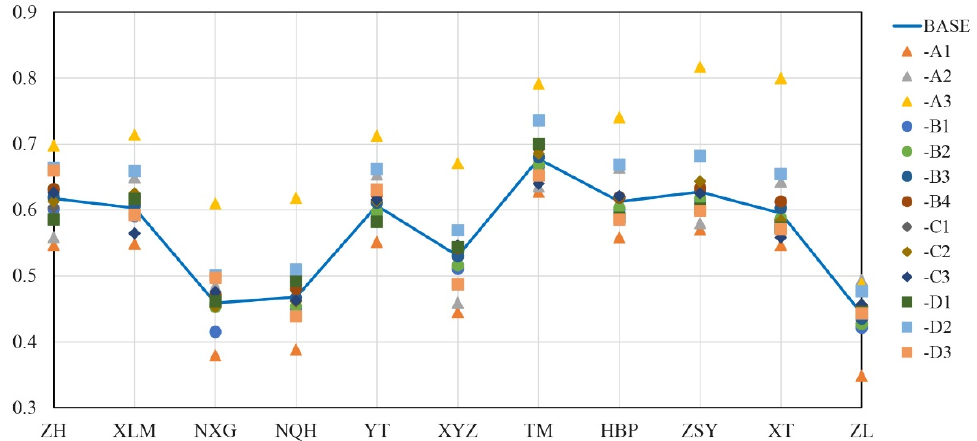
Figure 5. Comparison of the comprehensive score values of each township between original and single index weight removed. (The meaning of the abscissa in the figure is to use the first letters of the names of the locations to represent the towns. The indexes like “A1, A2…D3” express the meanings of index layer in Table 1 in turn.)